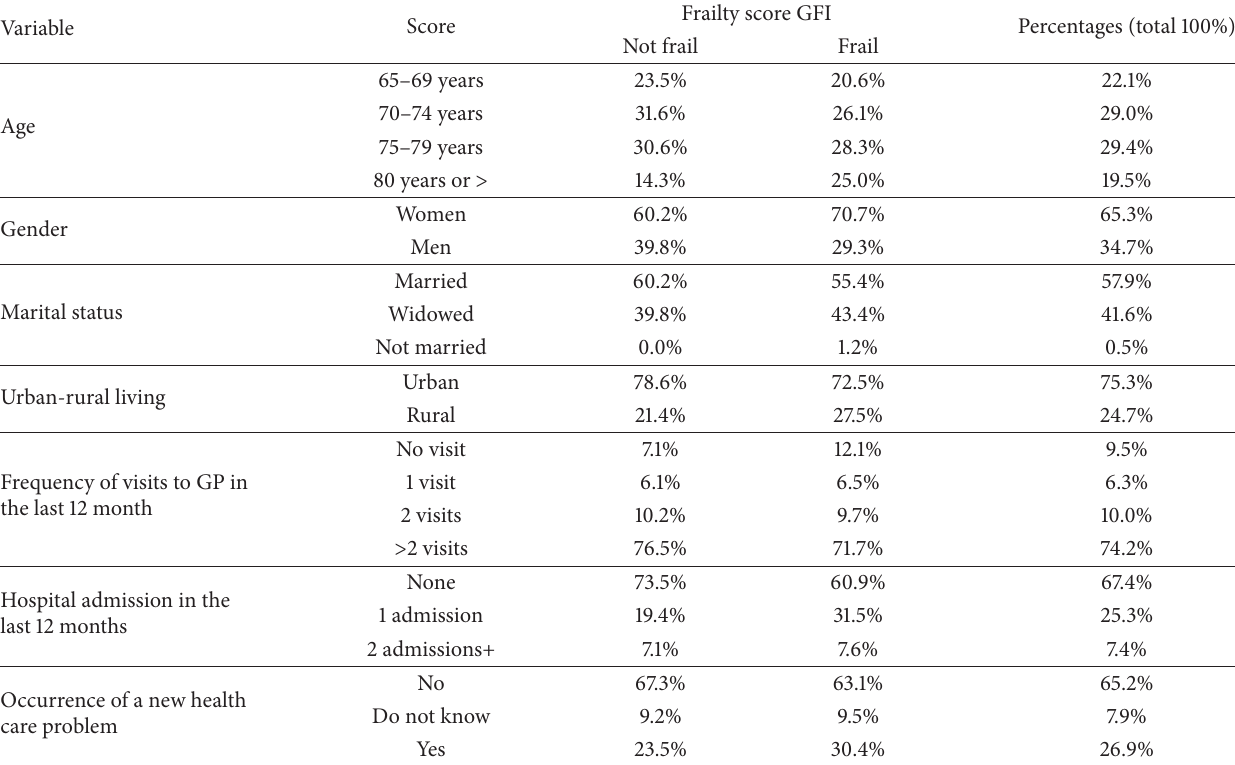
Table 1: Frequencies of sociodemographic data, visits to the general practitioner (GP), hospital admission, and occurrence of new health problems by frailty scores on Groningen Frailty Indicator (GFI), in %; 𝑛 = 190